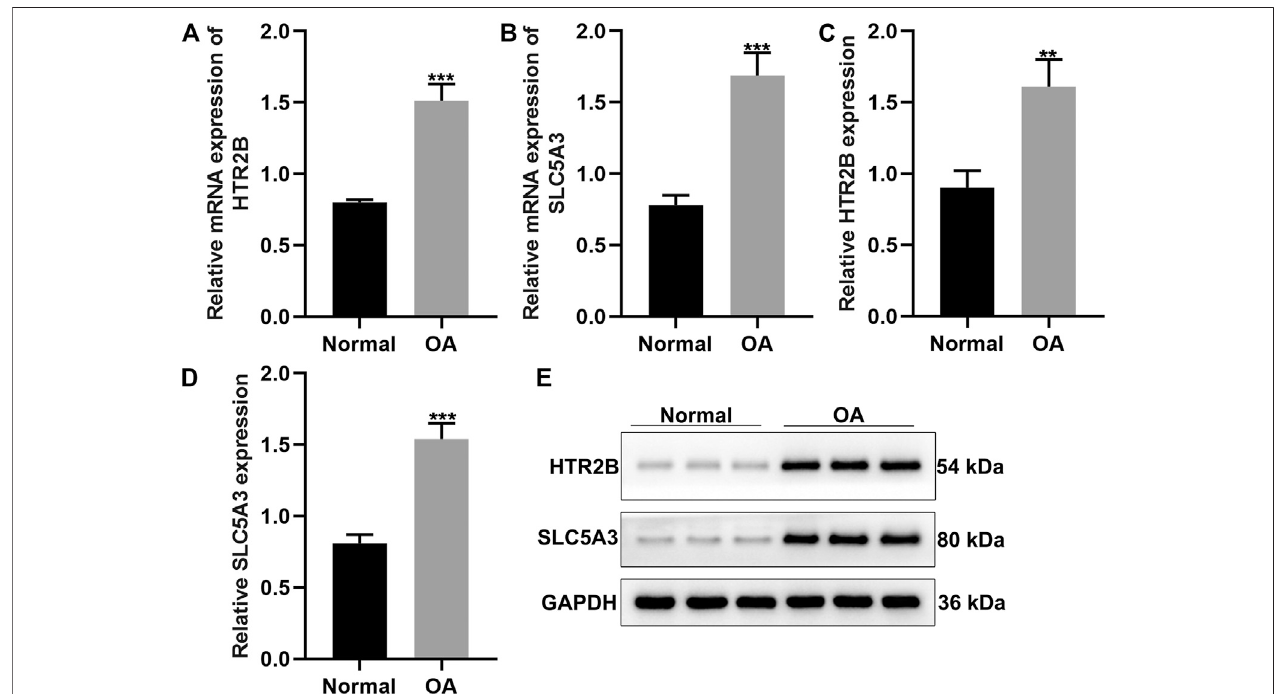
FIGURE 6 | Validation of HTR2B and SLC5A3 expression in OA synovial tissues. (A,B) RT-qPCR for the mRNA expression of HTR2B and SLC5A3 in OA and healthy synovial tissues. (C – E) Western blot for detecting the expression of HTR2B and SLC5A3 proteins in OA and healthy synovial tissues. ** p < 0.01; *** p <